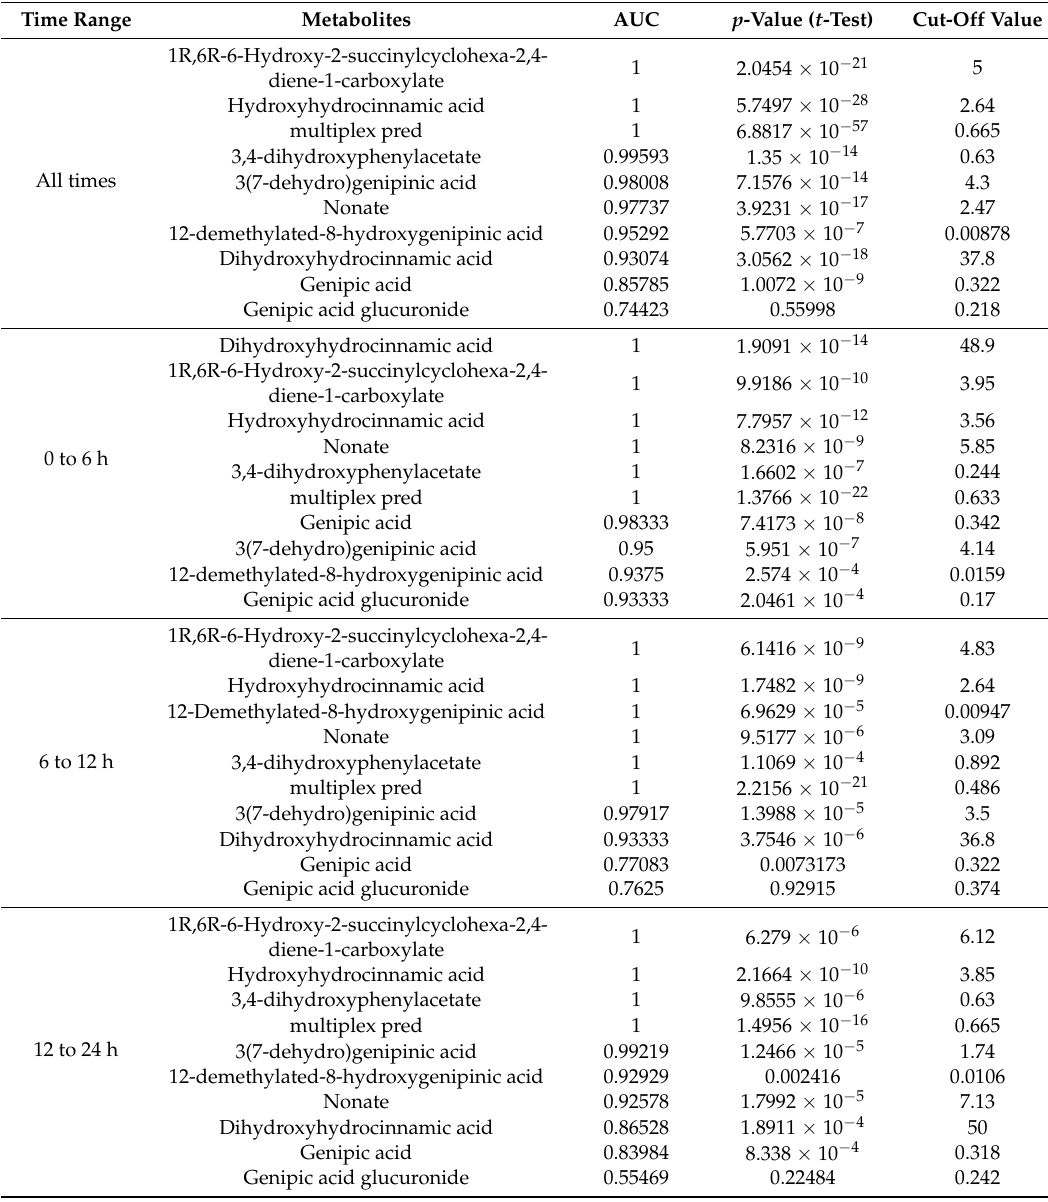
Table 2. Performance of selected metabolites at each time period as assessed by ROC